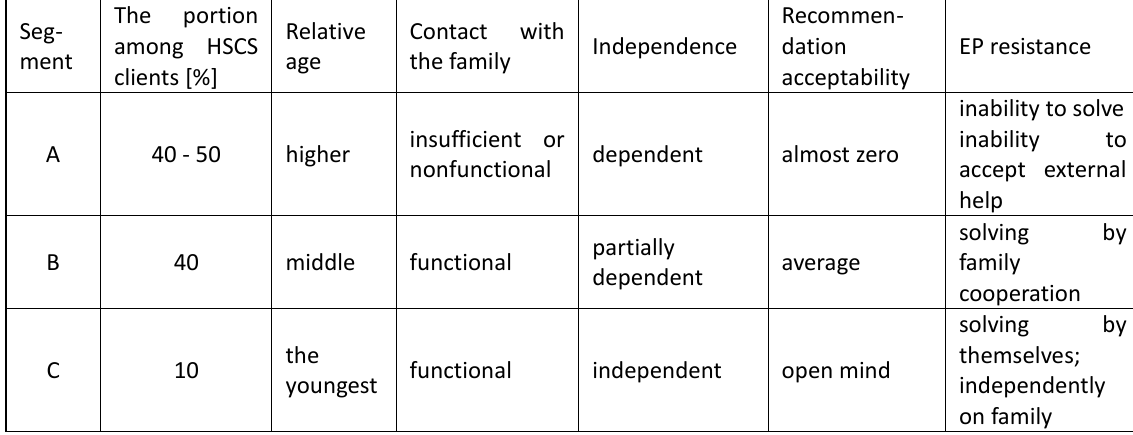
Table 2: The resistance to EP among the Home Social Care Services